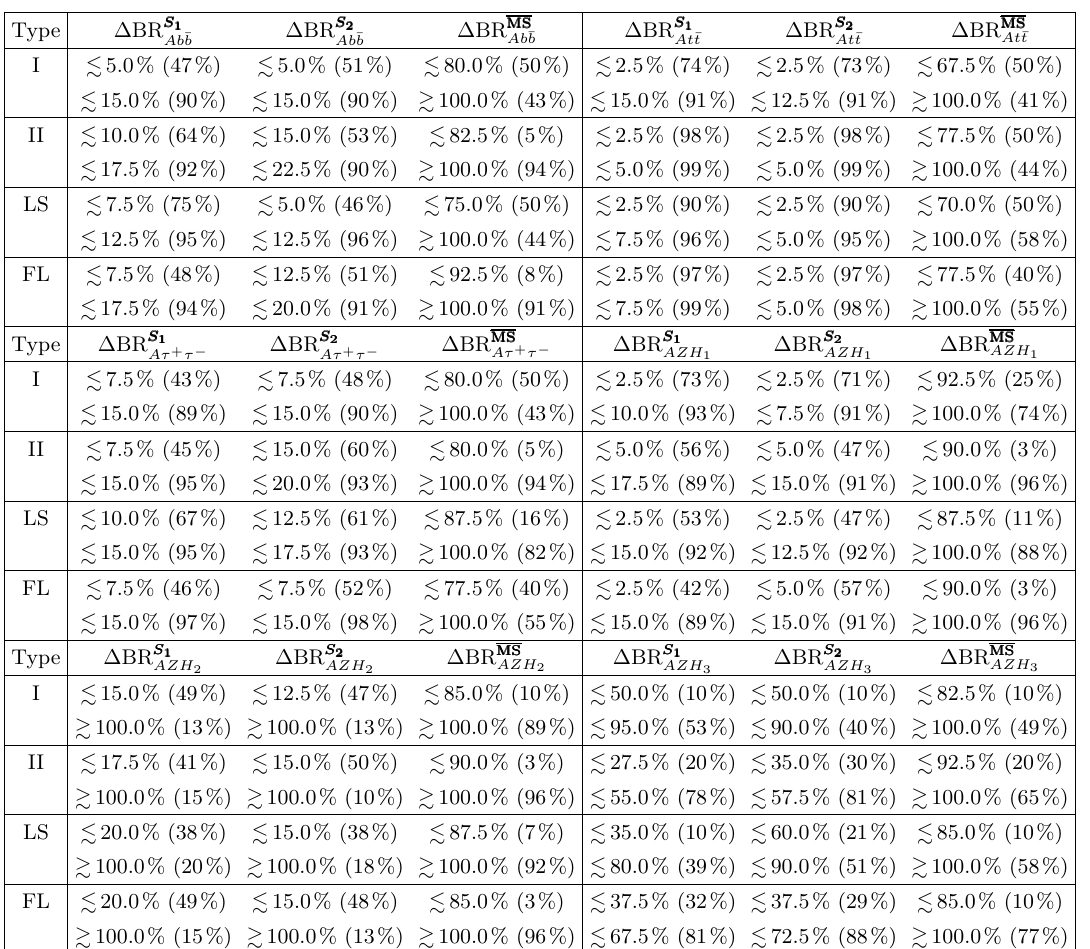
Table 28 . Relative size of the EW corrections to the BRs of the pseudoscalar A into b (cid:22) b , t (cid:22) t , (cid:28) + (cid:28) (cid:0) , ZH 1 , ZH 2 , and ZH 3 , for the four N2HDM types I, II, LS and FL ( H 2 is SM-like). channels as shown in table 27. 18 The results for the relative corrections (cid:1)BR of the pseu- doscalar decays for the scenarios where H is SM-like are displayed in table 28. We 2